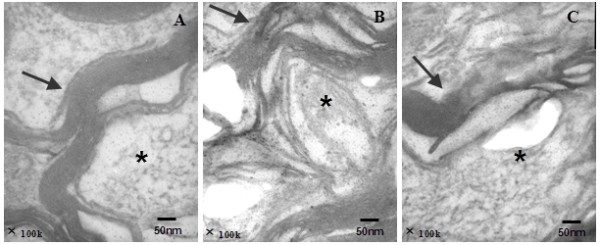
Ultrastructure of myelin nerve fibers in ischemic cortical area of rats, TEM. C: control group; M: model group; T: treatment group. The myelin sheath (Black arrow) and the neural axon (*) in control group were distinct and neat (A), and unclear or disappeared in model group (B), and those injuries was alleviated in treatment (C).